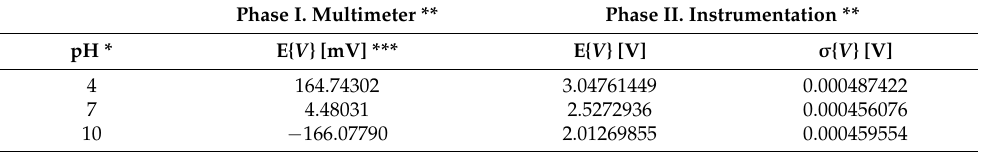
Table 1. Statistical parameters derived from pH sensor characterizations: Phase I and Phase